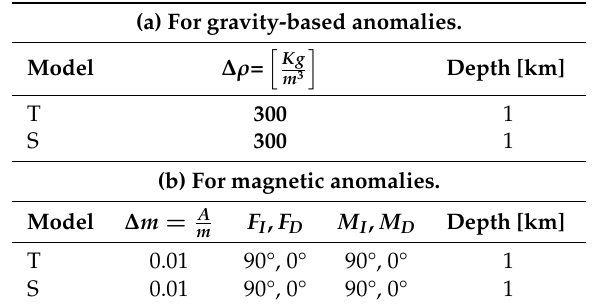
Table 1. Considered parameters to compute field anomalies in T and S models. (a) For gravity-based